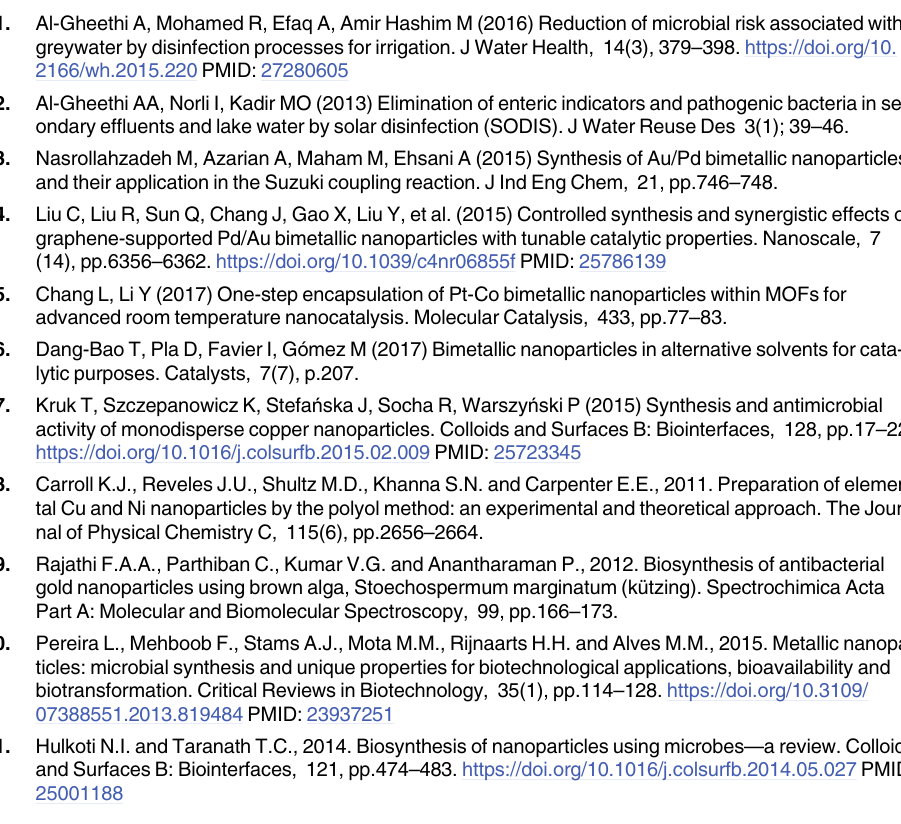
S1 Table. Coded and un-coded levels of the independent factors investigated in the present work. S2 Table. Central composite design arrangement and responses for inactivation of E . coli and S . aureus in greywater using bimetallic Zn/Cu NPs. S3 Table. Regression coefficient and their significance of the quadratic model for inactivat- ing E . coli and S . aureus seeded in greywater using bimetallic (Zn/Cu) NPs. S4 Table. The best operating parameters for inactivation of E . coli and S . aureus in grey- water using bimetallic Zn/Cu